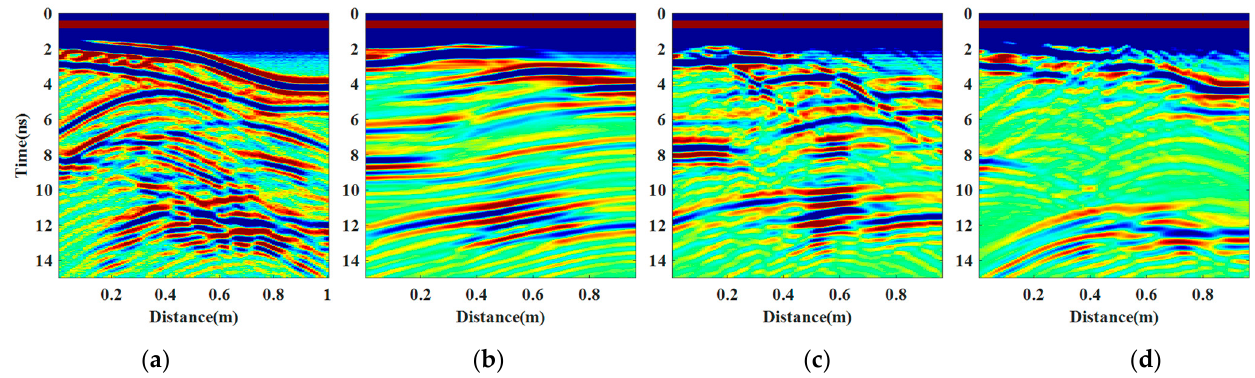
Figure 19. Comparison of the records: ( a ) observation records with 10% noisy data added; ( b ) forward records of the initial model; ( c ) forward records corresponding to the inversed model using the COPSO algorithm; ( d ) forward records corresponding to the inversed model using the TVIPSO algorithm.